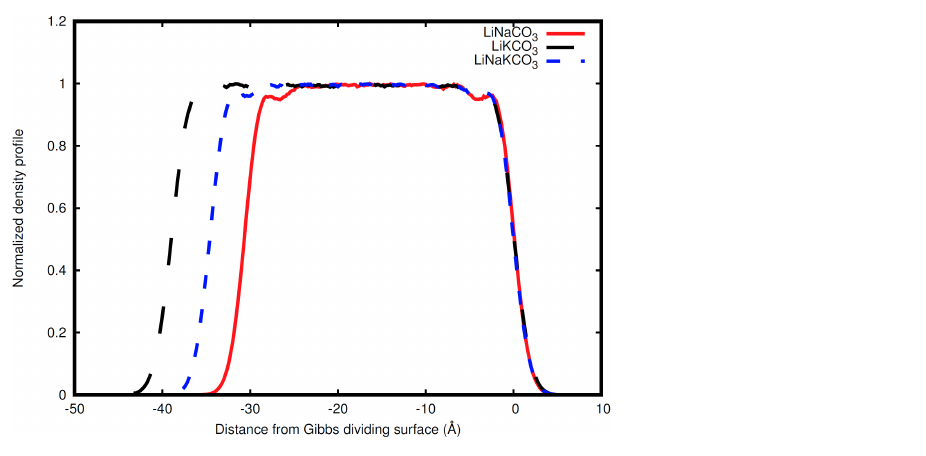
Figure 2 Normalized total density profile in the dimension perpendicular to the interface. The den- sities are normalized by dividing by the average liquid density. For each system, the right Gibbs dividing surface is positioned at 0 Å and the left interface provides a sense of the slab width because the xy area of the slab remains constant. Expansion of the slab is highly correlated with increasing concentration of the larger radius K ion. Each system shows structure near each interface that corresponds to structure within the liquid. Full-size DOI: